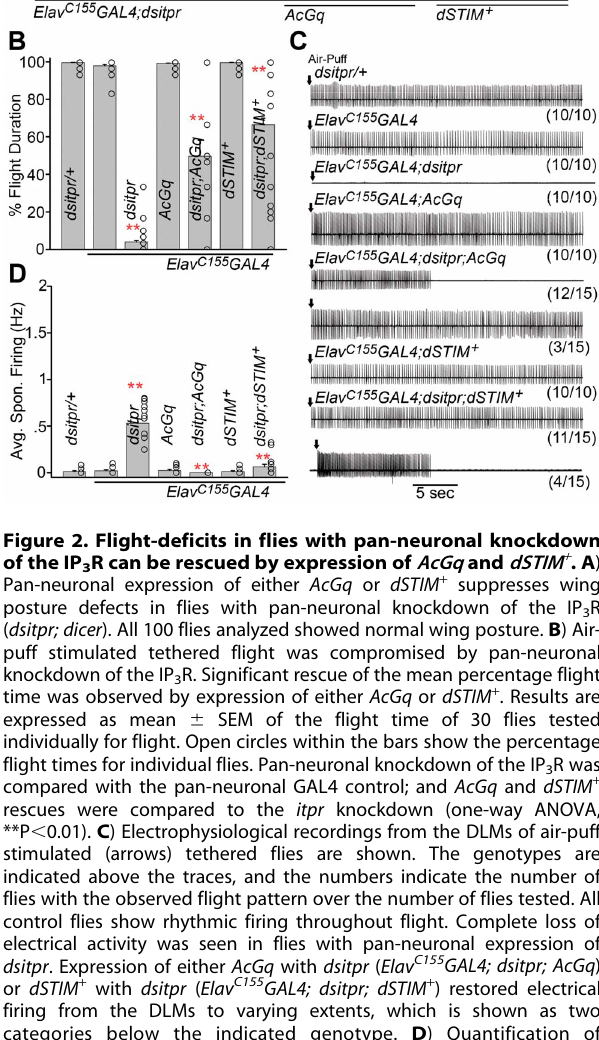
confirm signaling through the IP 3 R in the case of receptors shown in Figure 3A, it was of concern that in each case just one RNAi line for each GPCR showed flight deficits. We therefore tested the efficiency of GPCR knockdown for each RNAi strain, validated by rescue with either AcGq or dSTIM + , in a qPCR analysis. Two RNAi lines were selected for each validated GPCR; one that gave a flight defect and another that did not. The transcript level for each GPCR was quantified from isolated larval brains with pan- neuronal knockdown of the GPCR in the two selected RNAi lines.